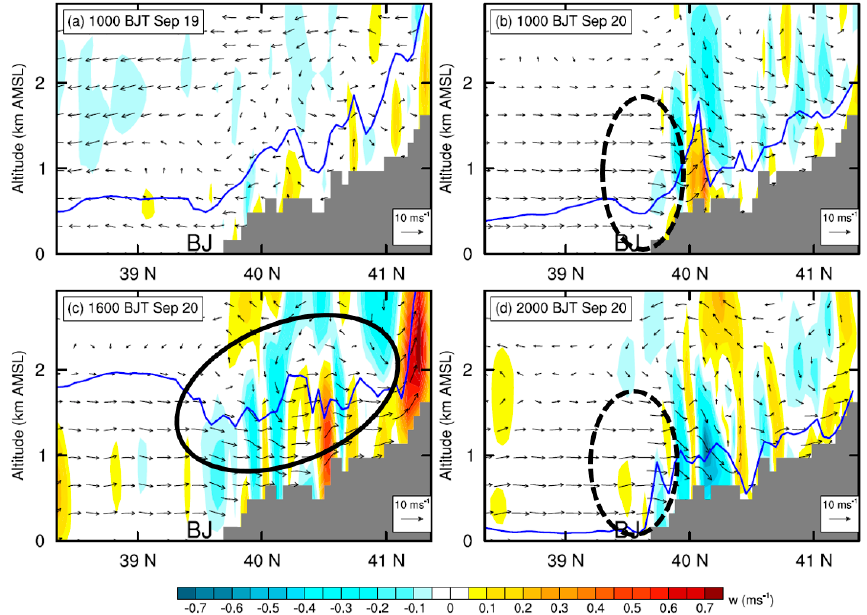
Figure 11. Similar to Figure 7, but for the vertical cross sections of simulated vertical velocity (w) at ( a ) 10:00 h BJT on 19 September, and ( b – d ) 10:00, 1600, and 20:00 h BJT on 20 September, overlaid with the wind vector fields.